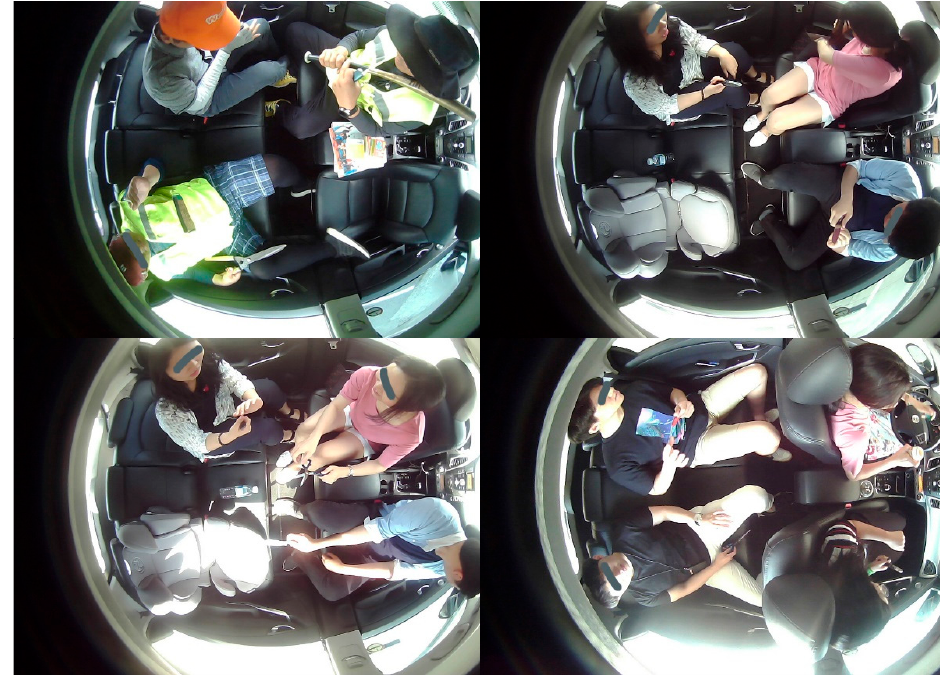
Figure 9. Images for examples of harmful objects in the cabin of an AV.